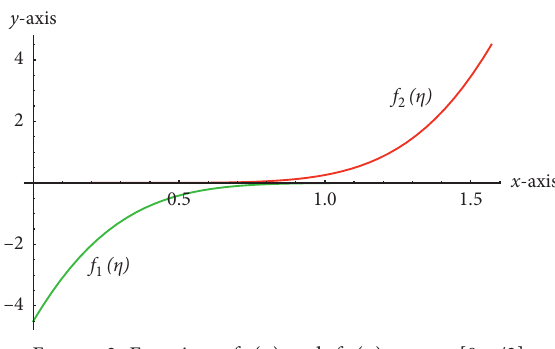
Figure 2: Functions f